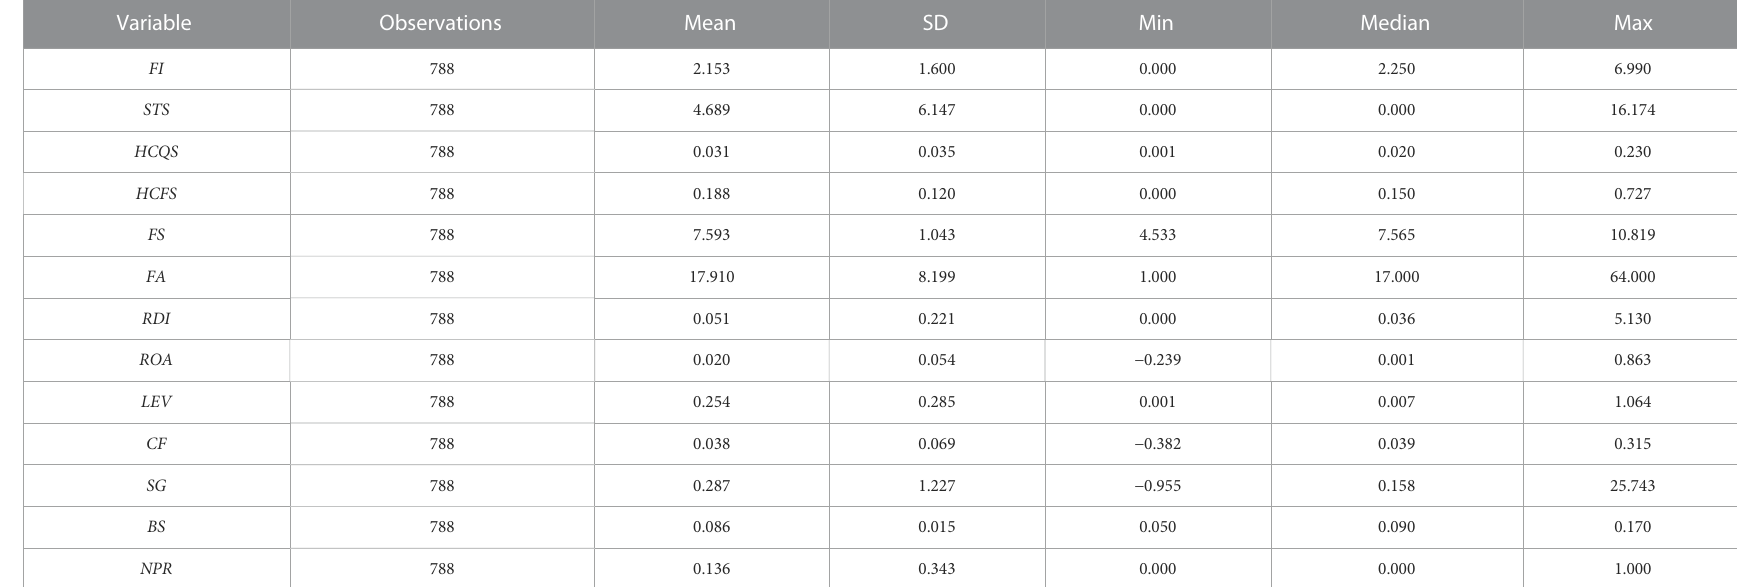
TABLE 2 Descriptive